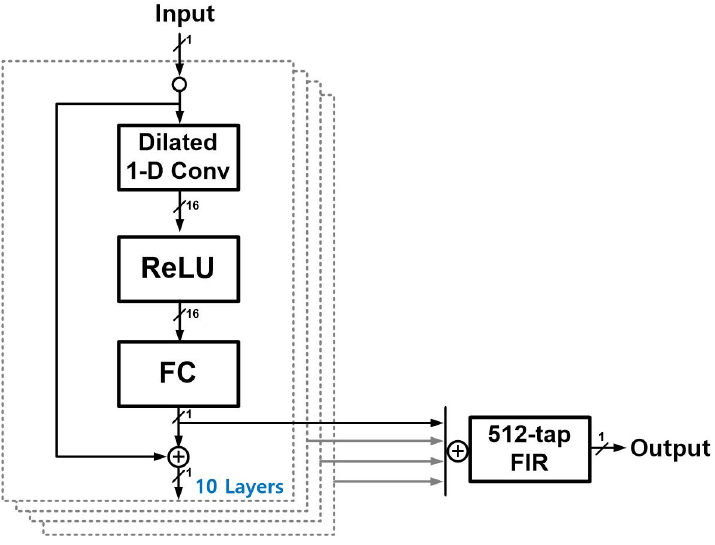
Figure 8. Propsed CNN model.